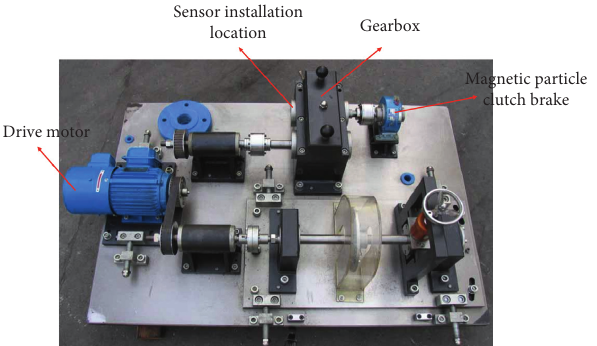
Figure 11: The experimental